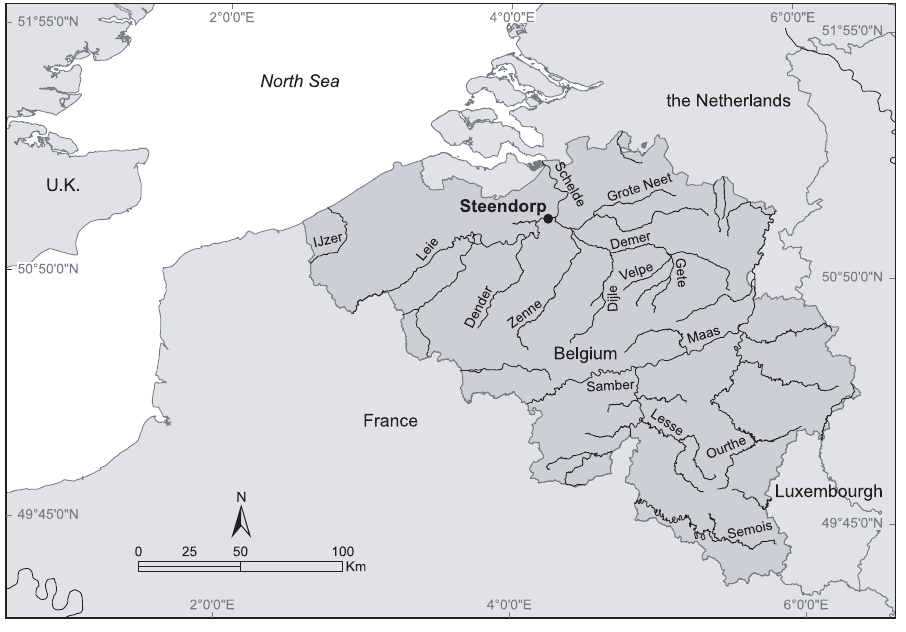
Fig. 1. Location of first record of Gobiosoma bosc in Belgium (●)